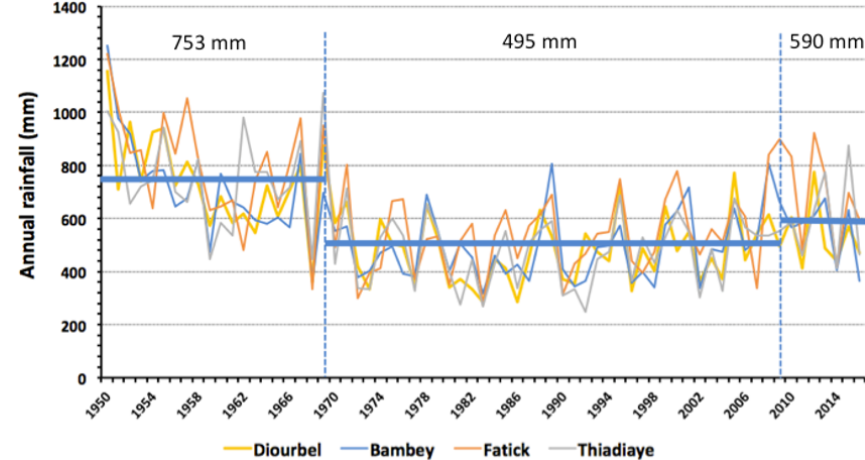
Figure 5. Evolution of the annual rainfall of the 4 climatic stations around the Diohine and Sob watersheds (from the East to West: Diourbel and Bambey in the North, Fatick and Thiadiaye in the South) to identify three homogeneous climatic period (1950–1969, 1970–2009 and 2010–2016), with the mean annual rainfall (in mm) for each considered period.